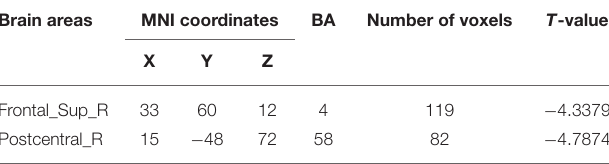
TABLE 2 | Brain regions with significant differences in PerAF between patients and HCs.